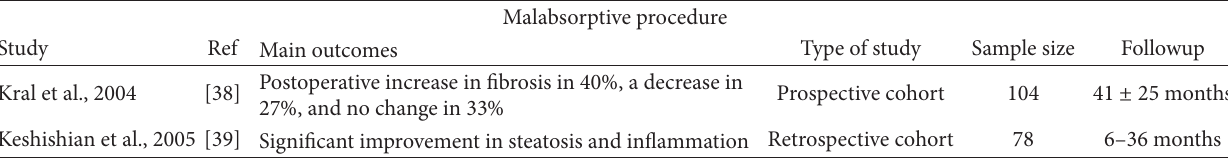
T 4: Summary of studies of malabsorptive procedure and their effect on NAFLD. Malabsorptive